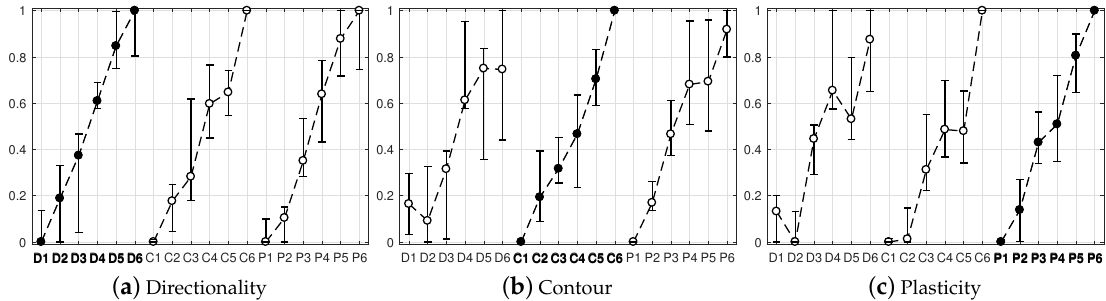
Figure 4. Results of experiment 2: median values and 95% confidence intervals of perceived strength of sculuptural quality attributes. Black markers indicate ratings for conditions that were intended to yield a graded increase in the respective attribute.